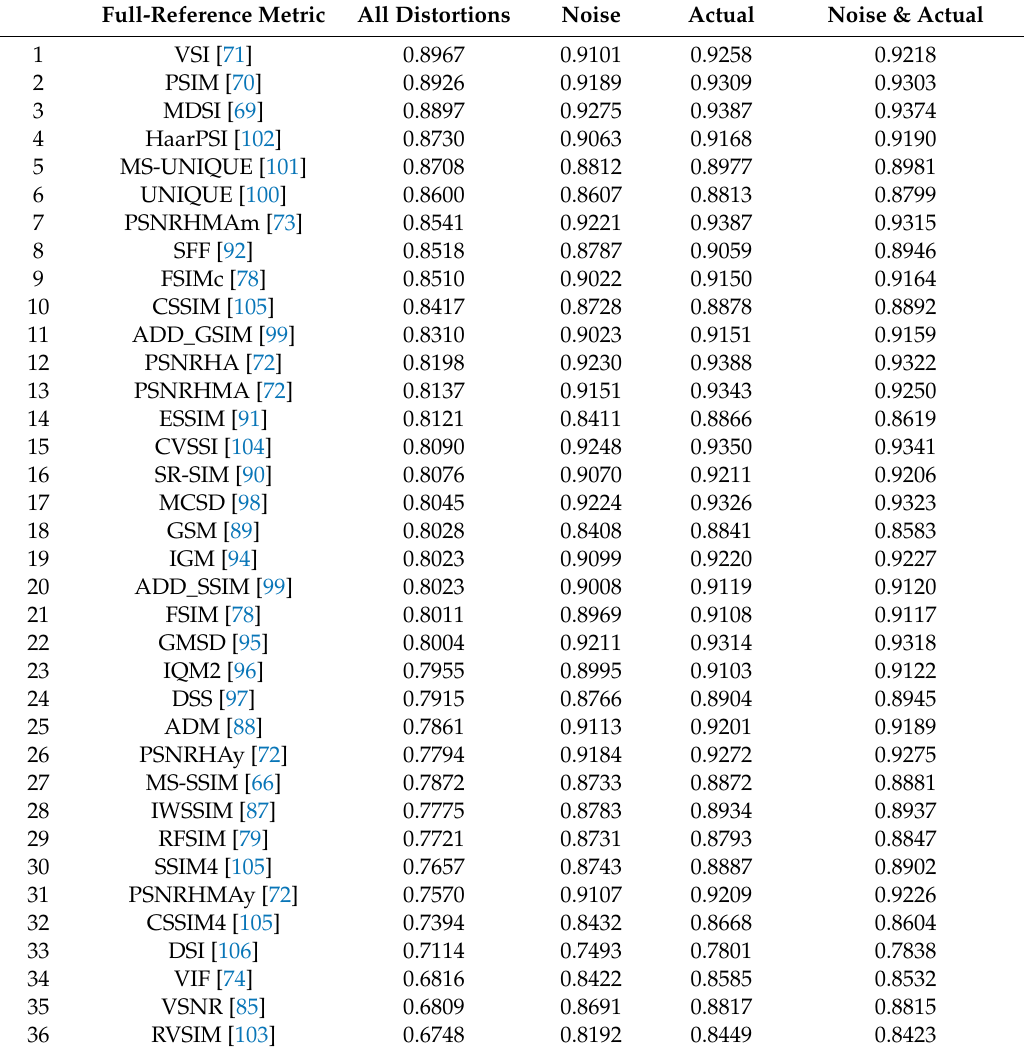
Table 2. Spearman rank order correlation coe ffi cient (SROCC) values for all distortion types and three subsets of the Tampere Image Database